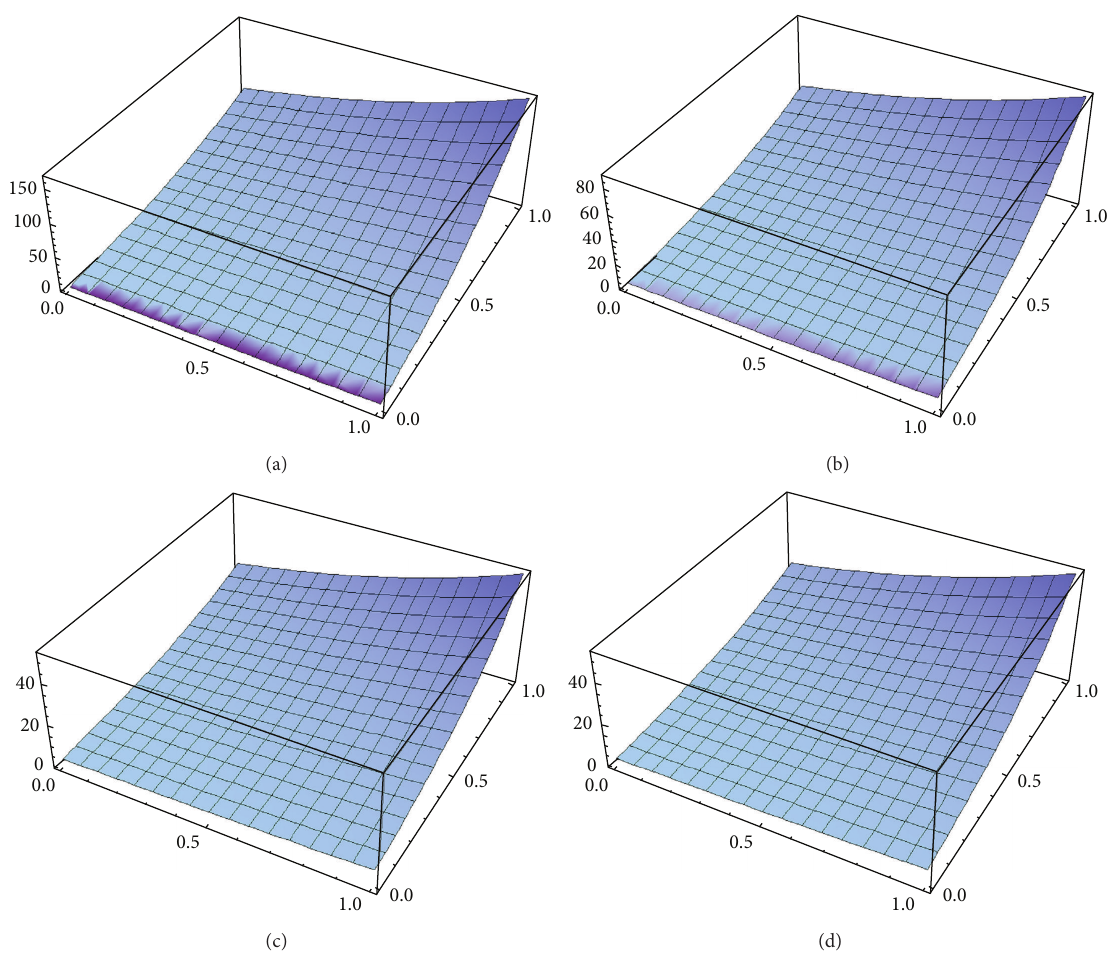
Figure 3: (a) 5-term approximate solution for 𝑢(𝑥,𝑡) and V (𝑥,𝑡) , in case 𝑦 = 1 , 𝑥 : 0 → 1 , 𝑡 : 0 → 1 , and 𝛼 = 0.6 . (b) 5-term approximate solution for 𝑢(𝑥,𝑡) and V (𝑥, 𝑡) , in case 𝑦 = 1 , 𝑥 : 0 → 1 , 𝑡 : 0 → 1 , and 𝛼 = 0.8 . (c) 5-term approximate solution for 𝑢(𝑥,𝑡) and V (𝑥, 𝑡) , in case 𝑦 = 1 , 𝑥 : 0 → 1 , 𝑡 : 0 → 1 , and 𝛼 = 1 . (d) Exact solution for 𝑢(𝑥,𝑡) and V (𝑥,𝑡) , in case 𝑦 = 1 , 𝑥 : 0 → 1 , 𝑡 : 0 → 1 , and 𝛼 = 1